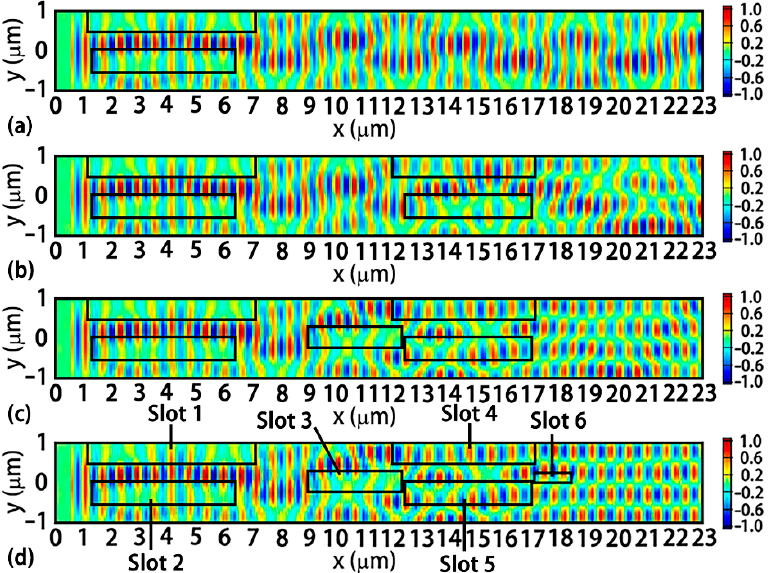
Figure 2. Electric field evolution ( E z component) of input TM 0 mode transmitted along the silicon waveguide which was etched by ( a ) slots 1 and 2, ( b ) slots 1, 2, 4, 5, ( c ) slots 1~5, and ( d ) slots 1~6.